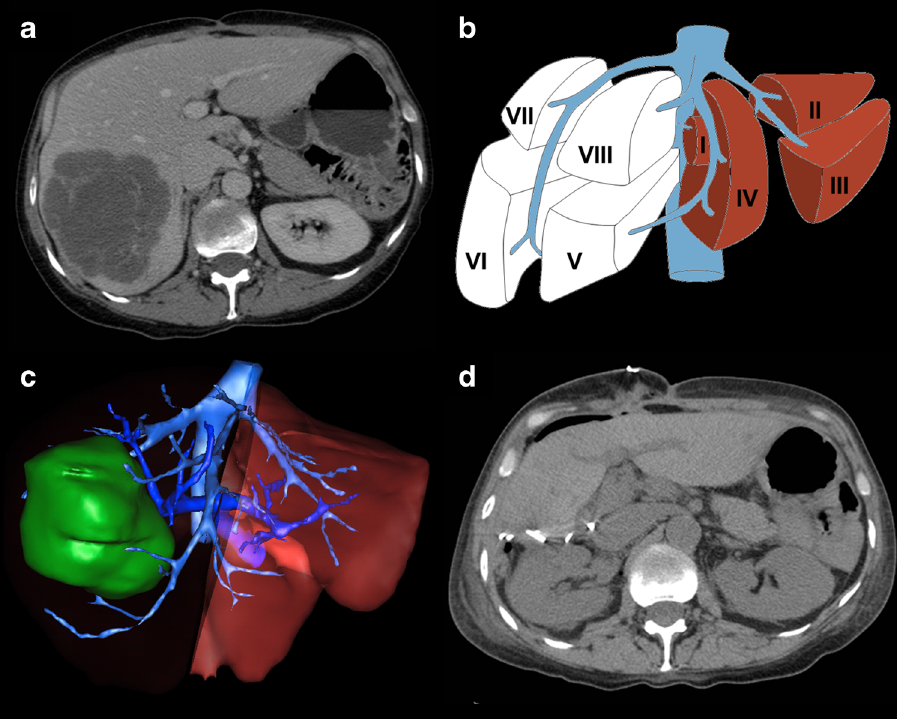
Fig. 4 Future liver remnant volume calculation in normal liver prior to right hepatectomy. a Axial enhanced CT image showing colorectal liver metastasis involving right posterior segments (VI and VII). b Resection diagram shows the intended complete right hepatectomy surgery planned. c Three-dimensional rendered im- age showing surgical planning for complete right hepatectomy. FLR/TLV ratio was estimated to be 33%. d Axial unenhanced CT image of the same patient shortly after complete right hepatectomy. Actual FLR/TLV ratio was calcu- lated to be 36%. Figure courtesy of Dr. Vandenbroucke-Menu; created with 3DVSP (IRCAD,